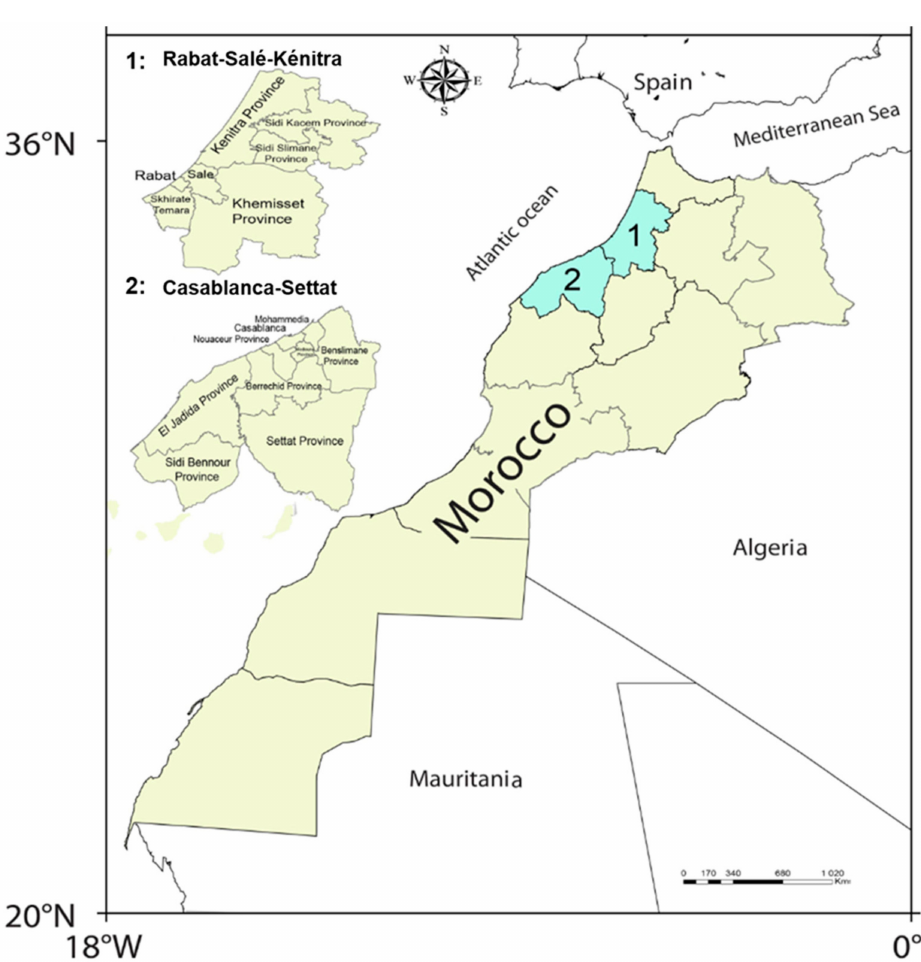
Figure 3. Rabat-Sal é -K é nitra and Casablanca-Settat regions, Morocco, (location of studied